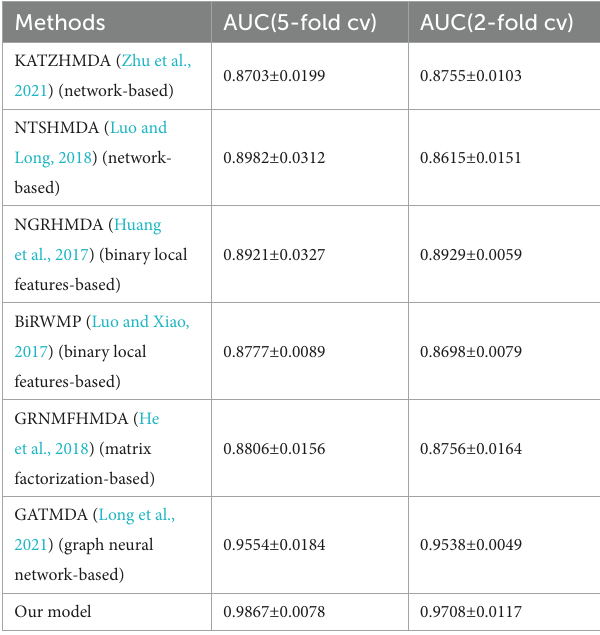
TABLE 1 Comparison performance between our model and state-of-the- art models based on HMDAD dataset.